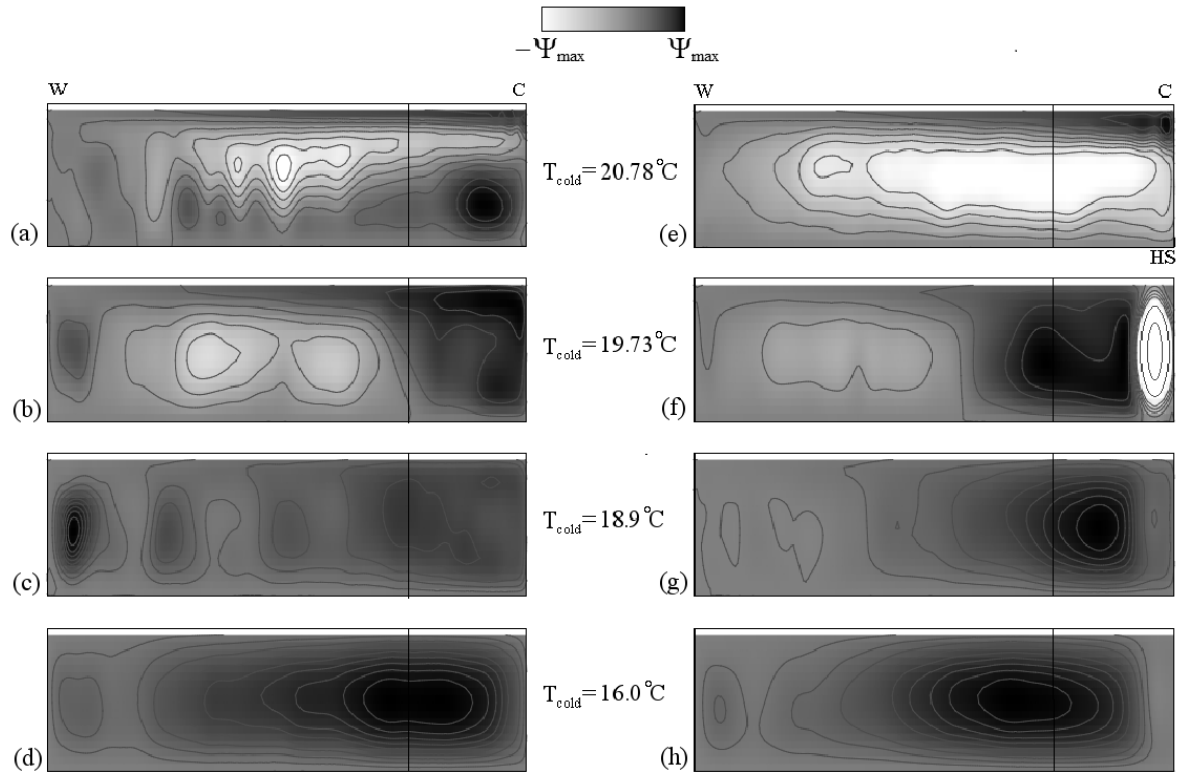
Fig. 2. Averaged streamfunction ( 9 ) patterns for the quasi-stationary parts of different runs. The gray-scale values cover the interval between − 9 max (white) and 9 max (black), for actual magnitudes see Fig. 3c and f. Correspondingly, dark gray regions reflect positive (clockwise) local vorticity. In the uppermost two snapshots, labels “W” and “C” denote the warming and cooling sides. Label “HS” marks the position of the bottom “hot spot”. Figures 2a,b,c and d correspond to the “no hot spot” scenario, i.e. T spot = T ref = 25 ◦ C. The transition from a multi-cellular weak convection state to a DWF state is clearly visible as a function of T cold . In Fig. 2e,f,g and h the same transition is shown in the case of T spot = 30 ◦ C. In Fig. 2e the presence of the hot spot initiates a marked two-cell convection along the whole basin, which – at T cold = 19 . 73 ◦ C – develops to a full-depth counterclockwise Benard cell above the hot spot (Fig. 2f), that transfers momentum to the neighboring anticyclonic downwelling. In Fig. 2g the full-depth DWF state is present, and the counterclockwise cell already vanished. Note, that in the “hot spot” case, the marked one-cell convection is visible at T cold = 18 . 9 ◦ C, unlike in the “no hot spot” case. The vertical lines in each snapshot represent the left boundary of the region over which the mean value h w i polar (see Fig. 3b and e) is evaluated.